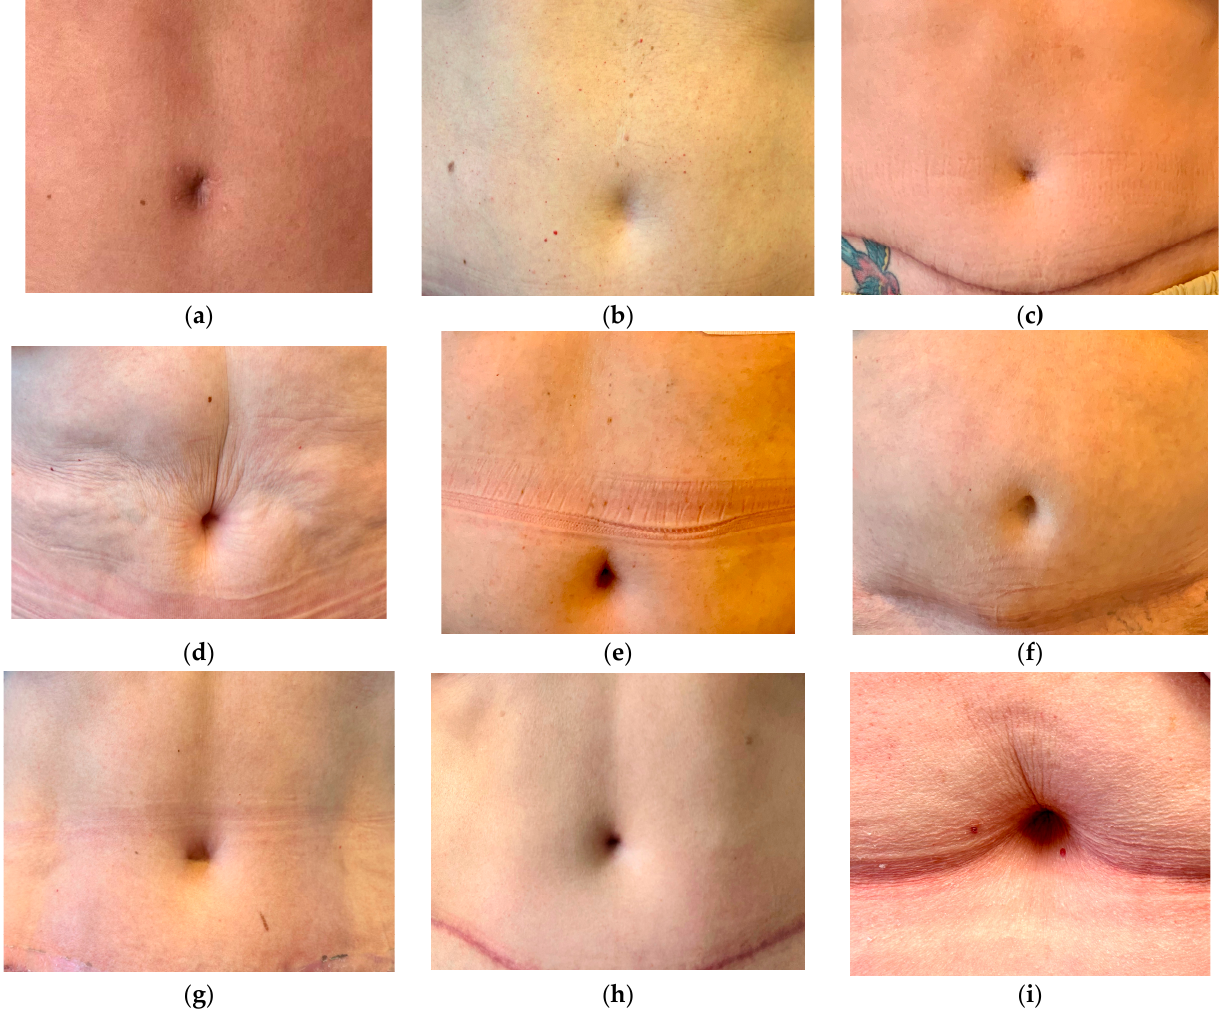
Figure 5. Results after neo-umbilicoplasty. ( a ) In the beginning, the technique of Yousif [9] was used. The transcutaneous stitches can cause visible scarring. ( b , c ) Less defined umbilicus in skinny patients and due to wide resections at the beginning of the technique. ( d – i ) Patients with good results after neo-umbilicoplasty. Modification to scarless technique with sutures between the rectus sheath and the abdominal wall dermis. The technique produces a scarless umbilicus. Hooding develops over time.